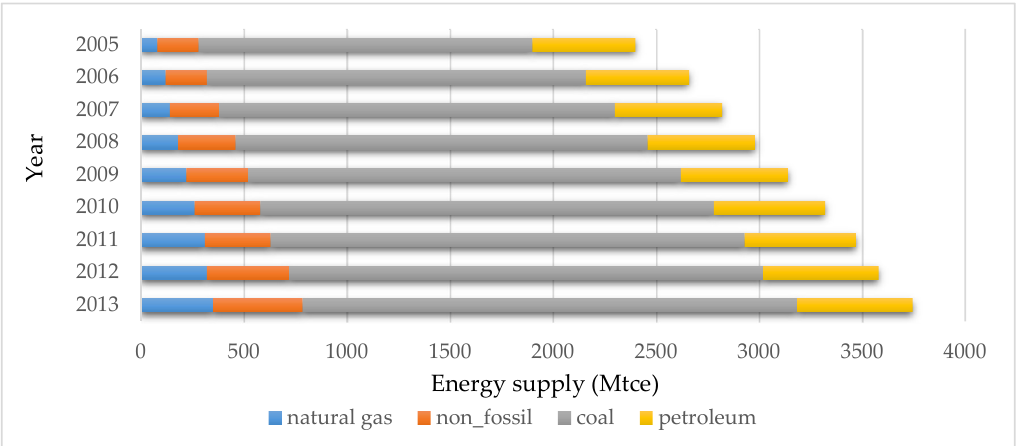
Figure 8. China’s energy supply structure.